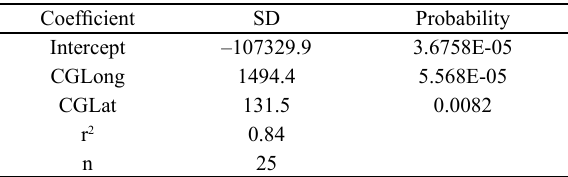
Table 3. – Results of the linear multiple relationship between annual catch and centre of gravity in longitude (CGLong) and latitude (CGLat). SD, standard